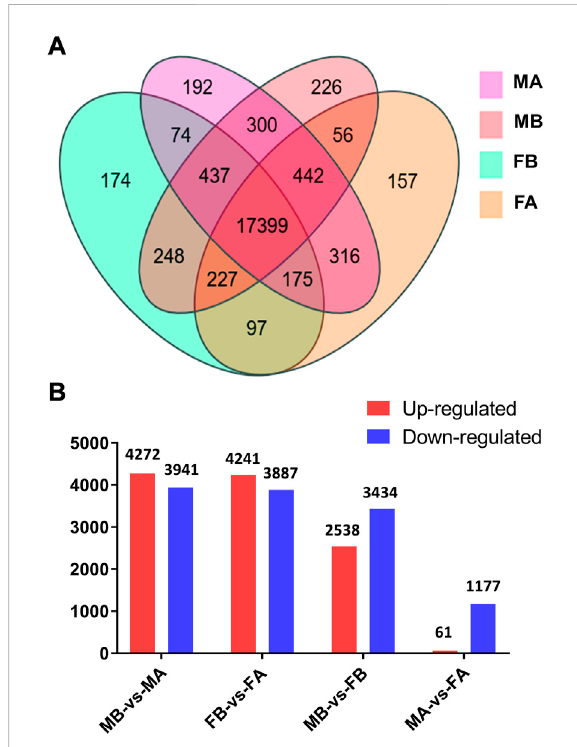
FIGURE 2 Expression of unigenes in D. citri samples. (A) Venn diagram of unigenes in the FA, FB, MA and MB of D. citri . (B) Number of DEGs identi fi ed by a pairwise comparison of the four samples. FA, female antennae; FB, female body; MA, male antennae; MB, male